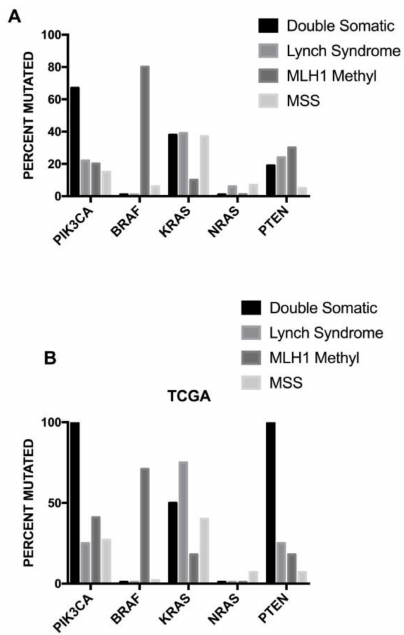
Figure 5. Distribution of somatic mutations in colorectal cancers subdivided into four tumor groups: double mutant (i.e., colorectal cancer samples containing two or more somatic mutations in genes encoding mismatch repair proteins), Lynch syndrome, MLH1-hypermethylated, microsatellite stability (MSS). The upper panel ( A ) shows the data reported by Cohen and coworkers [114] and the lower panel ( B ) the data reported in the TCGA study